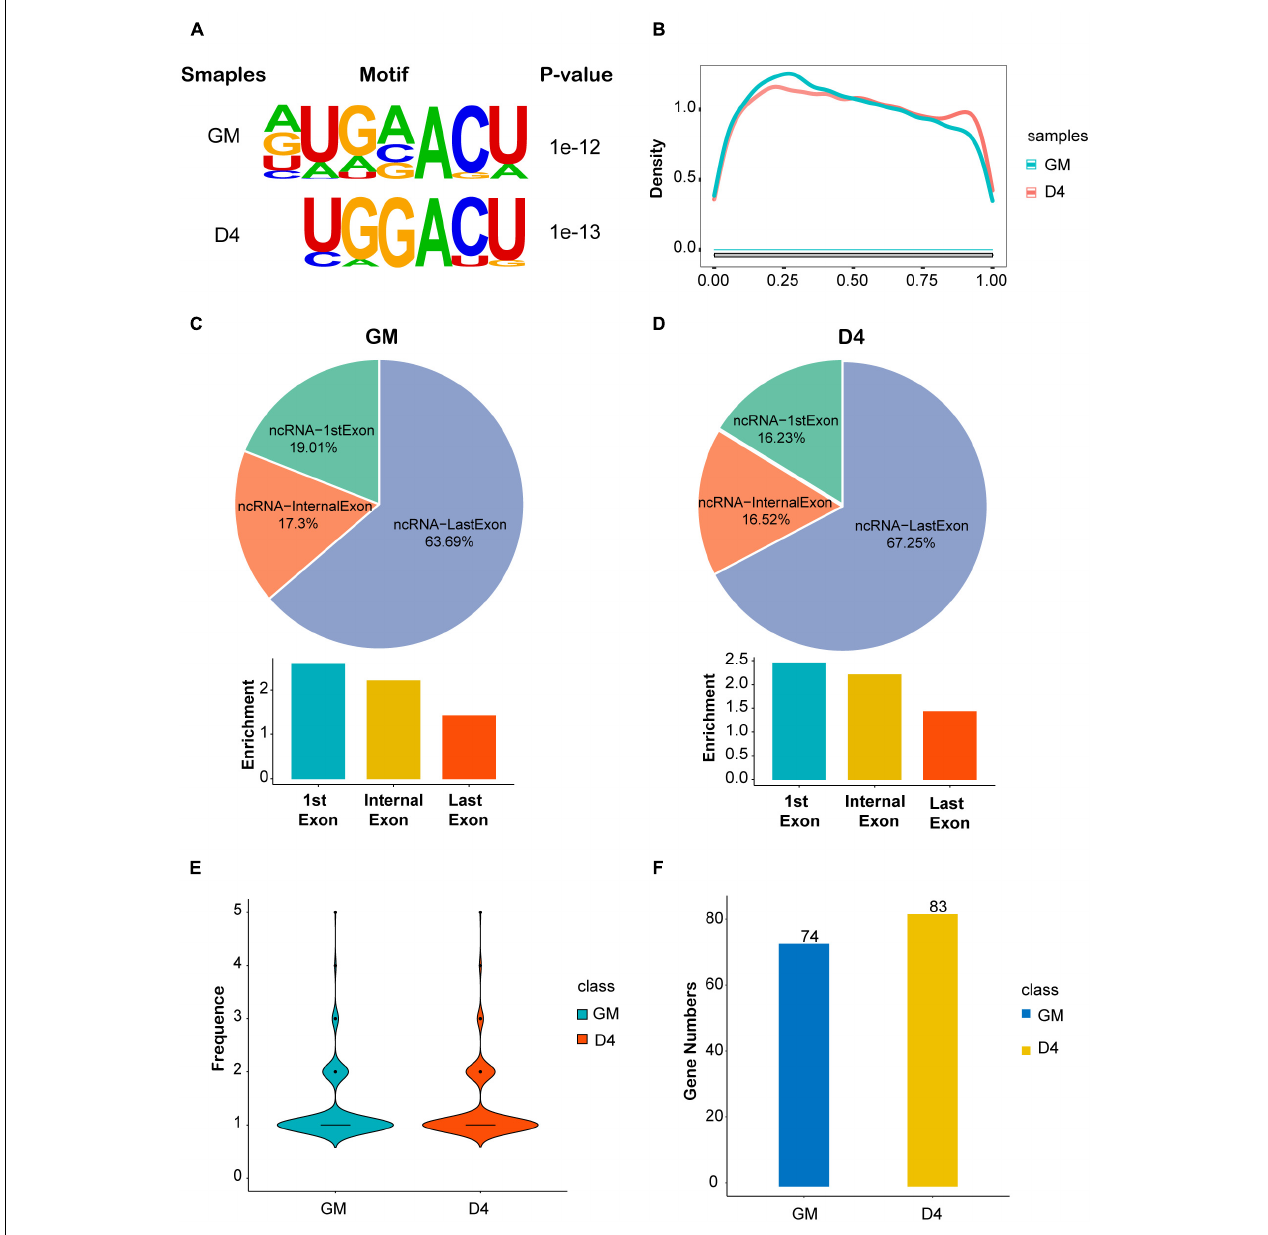
FIGURE 2 | Features of lncRNA m 6 A methylation in undifferentiated and differentiated muscle. (A) The enriched consistent motif of m 6 A peaks in lncRNAs in GM and D4. (B) Metagene profiles of enrichment of all m 6 A peaks across lncRNAs transcriptome. (C) The top: pie charts represent the proportion of m 6 A peaks in the three regions of lncRNAs at GM. The bottom: histogram represents the relative enrichment of m 6 A peaks in the three regions of lncRNAs at GM. (D) The top: pie charts represent the proportion of m 6 A peaks in the three regions of lncRNAs at D4. The bottom: histogram represents the relative enrichment of m 6 A peaks in the three regions of lncRNAs at D4. (E) The frequence of m 6 A Peak Numbers in lncRNAs in GM and D4. (F) Bar plot shows the Numbers of m 6 A methylated lncRNAs in GM and D4. Blue represents 74 hyper-methylated lncRNAs in GM, while yellow represents 83 hyper-methylated lncRNAs in